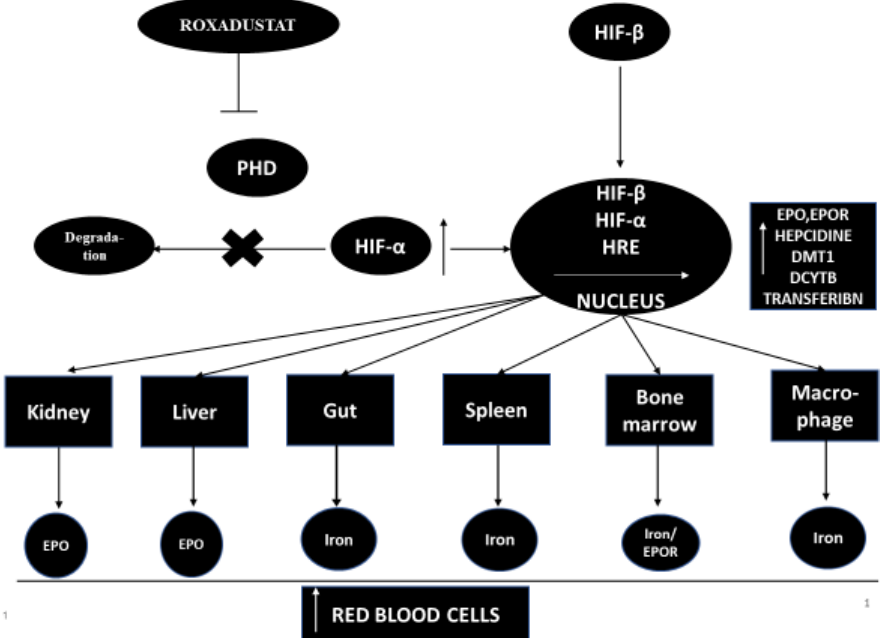
Figure 1. The mechanism of action of the HIF-PHD inhibitor. DCYTB—duodenal cytochrome b reductase 1, DMT1—divalent metal transporter-1, EPO—erythropoietin, EPOR—erythropoietin receptor, HIF—hypoxia-inducible factor, HRE—hypoxia response element, PHD—propyl-4-hydroxylase domain protein.